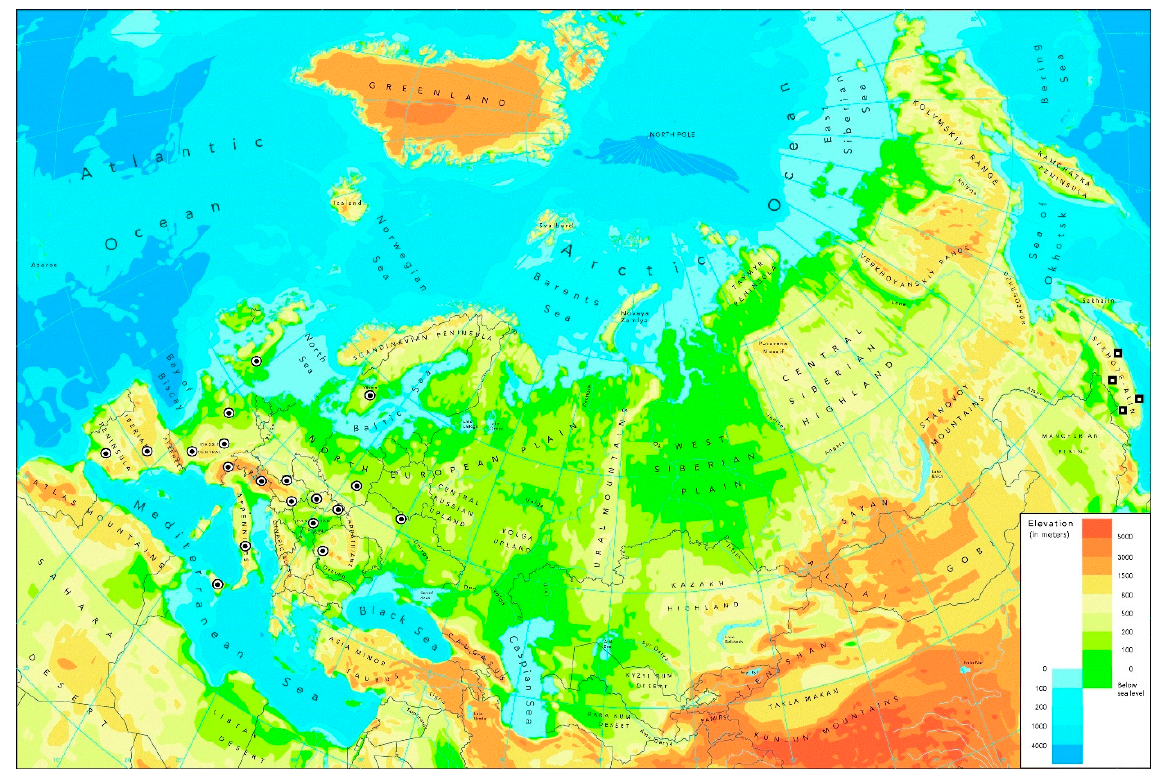
Figure 2. Distribution map of Hypebaeus (Hypebaeus) flavipes (Fabricius, 1787) (circles) and Hypebaeus (Hypebaeus) cooteri Tshernyshev, sp. nov. (quadrates): Source of the map: https://www.eea.eu- ropa.eu/legal/copyright. Copyright holder: European Environment Agency (EEA).